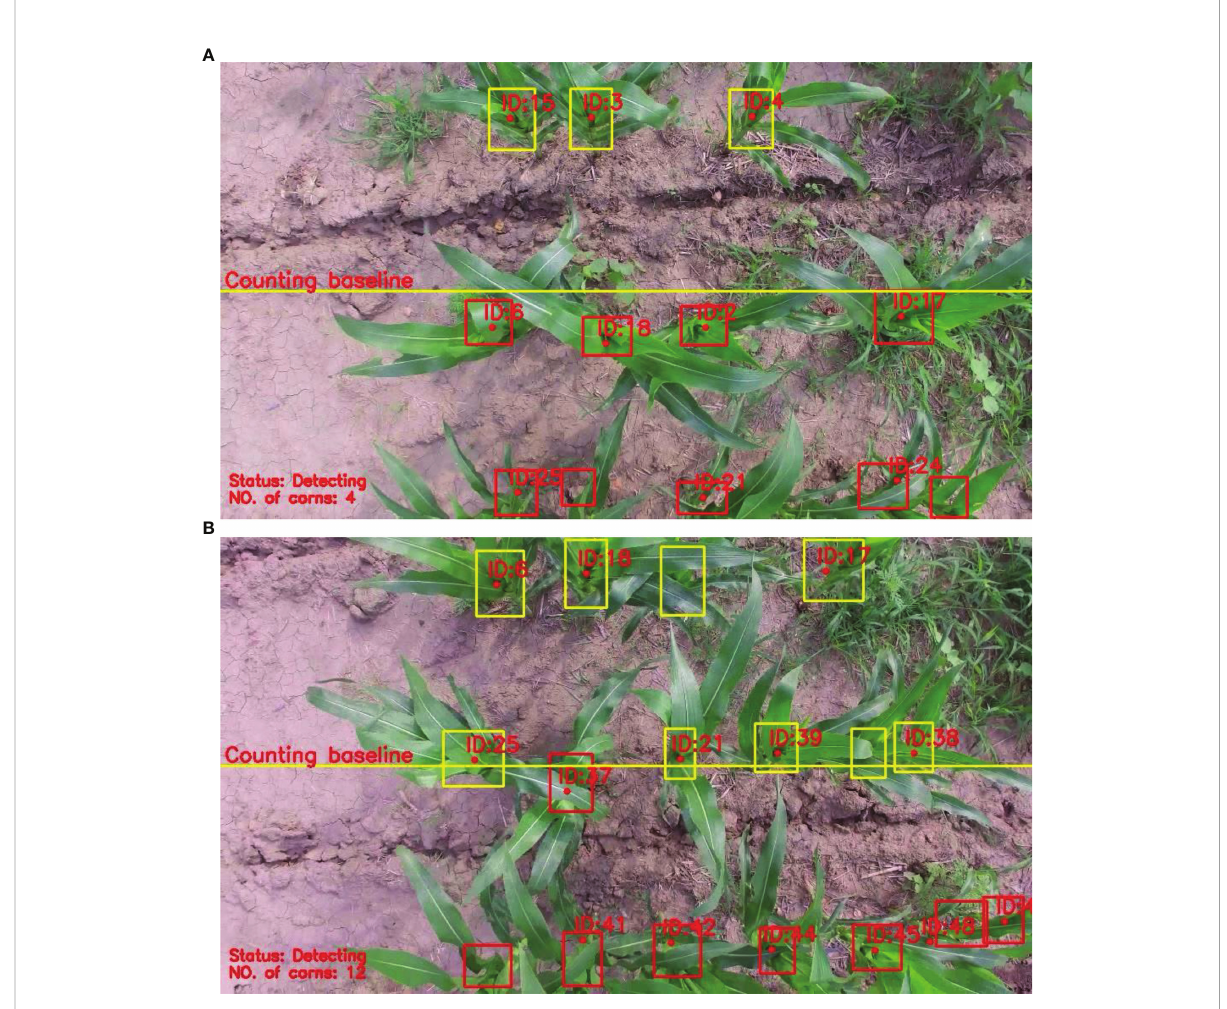
FIGURE 9 Visual video counting result of the algorithmic. The number on the bounding box is the ID of the mazie plant being tracked, and the solid point is the center of the mazie plant being tracked. The test video contains a total of 311 frames. In the fi gure, the 104 and 241 are typical frames. (A, B) shows the result in the 104th frame and 241th frame, respectively. Corrections has been post in the Production